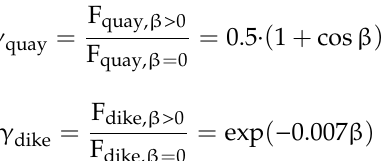
Figure 17. Variation of the reduction factor as function of wave angle.